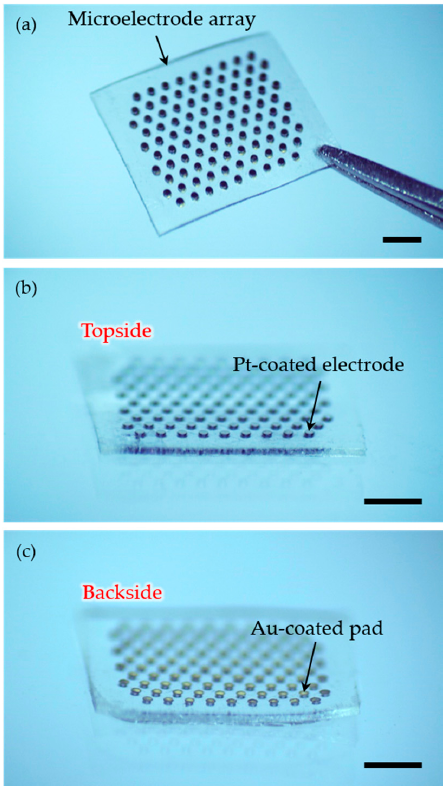
Figure 4. Photographs of the fabricated 3D microelectrode array: ( a ) top view of the array in a dimension of 4.4 mm × 3.8 mm and ( b – c ) its side views showing ( b ) the topside containing stimulating electrode sites and ( c ) the backside containing the connection pads. The scale bars are 1 mm.